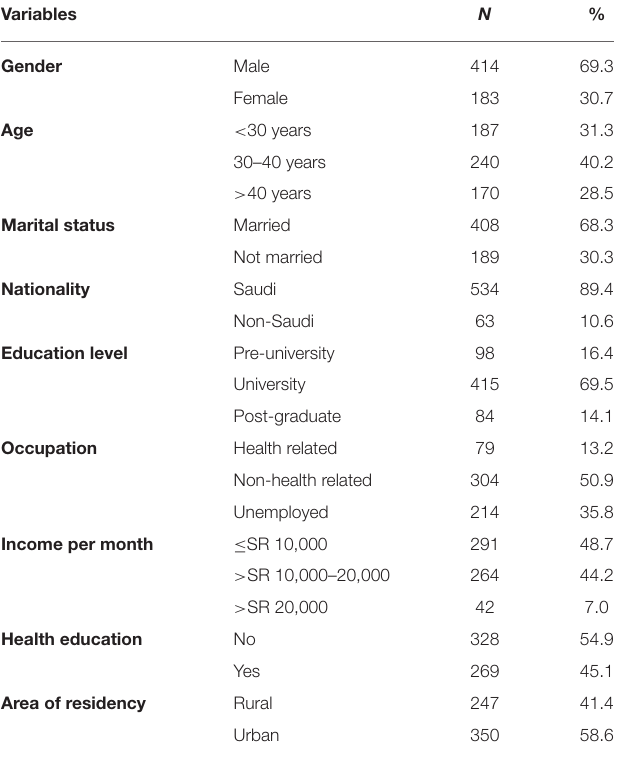
TABLE 1 | Demographic characteristics of